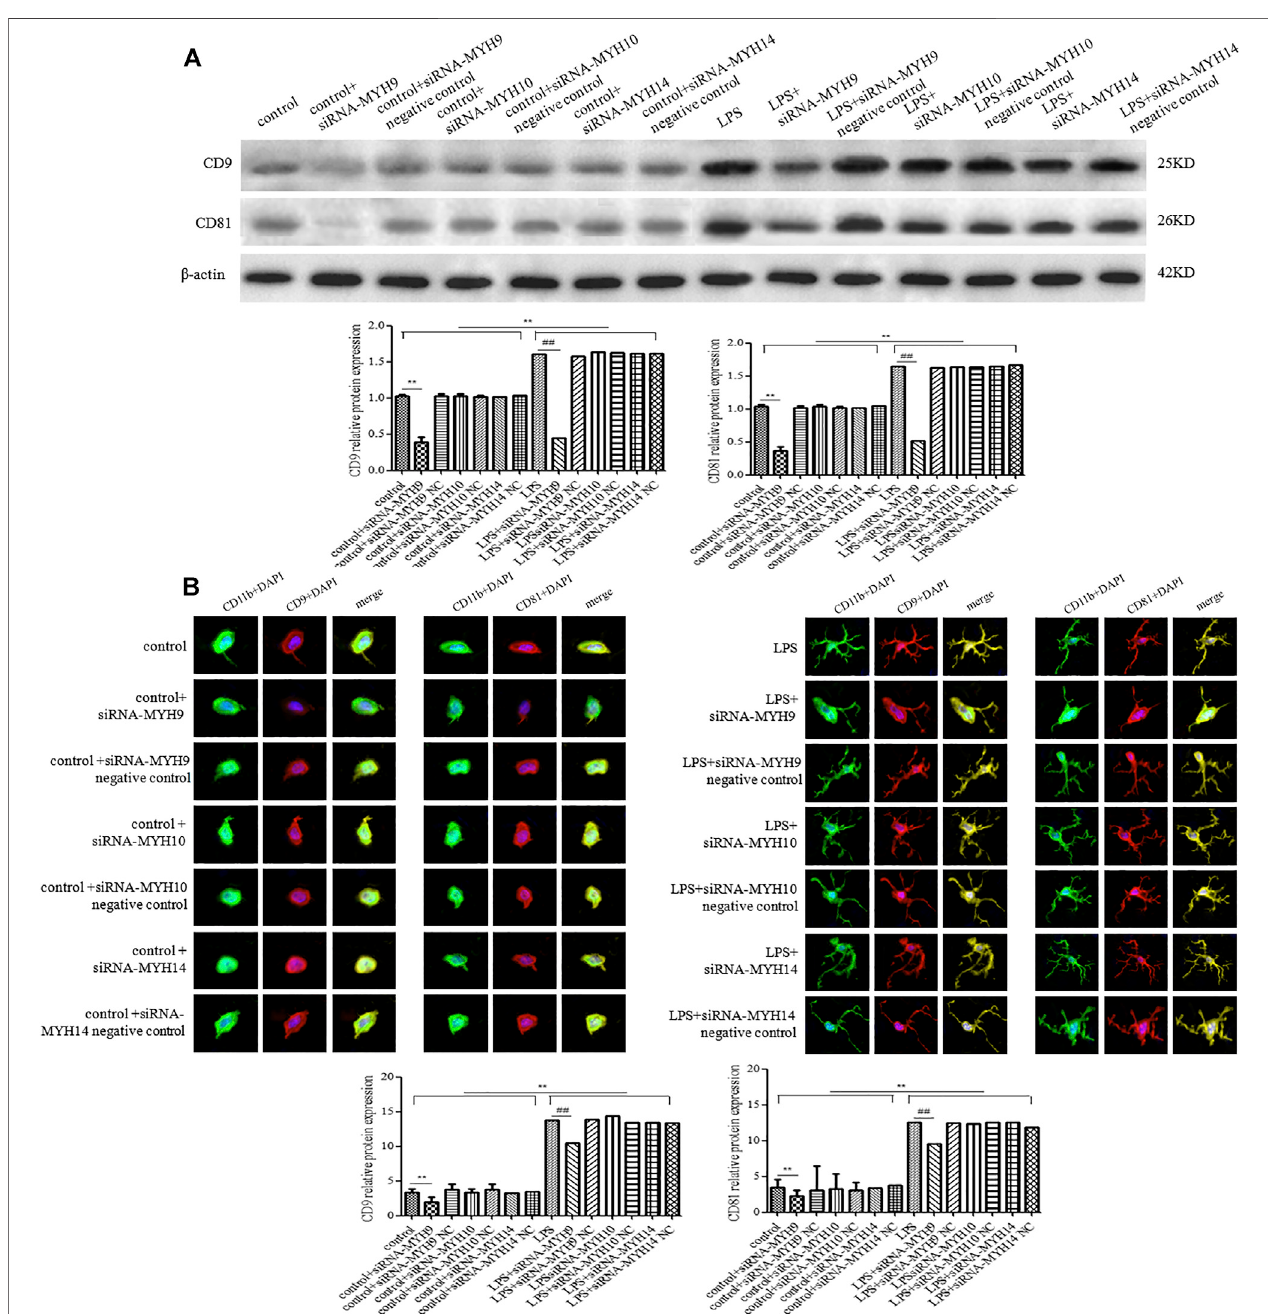
FIGURE 5 | Transfection of siRNA-MYH9, but not siRNA-MYH10 or siRNA-MYH14 inhibited exosome release from microglial cells stimulated by LPS. For transfection,microglialcellsweresub-culturedin24-wellplatesatadensityof3 × 10 5 cells/ml.TheextractedexosomesweregroupedbasedontransfectionwithsiRNA or siRNA into microglial cells. Whether control or LPS stimulation cells were transfected with siRNA-MYH9, siRNA-MYH10, or siRNA-MYH14 at a fi nal concentration of 100 nM for 48 h. Microglial cells stimulated by 1 mg/ml LPS for 24 h, microglial cells transfected with siRNA followed by 24 h LPS stimulation, microglial cells transfectedwithsiRNAnegativecontrolfollowedby24 hLPSstimulation. (A) TheCD9andCD81proteinexpressionlevelsforeachgroupofexosomewereexaminedby western blotting. Western blots were quanti fi ed. Nine independent experiments were analyzed. A histogram depicted the quantitative representations of the protein expressionlevelsofCD9andCD81foreachgroup. (B) Microglialcellswereimmuno fl uorescentlystainedwithanti-CD9oranti-CD81(red),togetherwithCD11b(green), and DAPI for nuclei (blue). Stained cells were examined by confocal microscopy. Scale bars (cid:2) 10 μ m. A histogram depicted the quantitative fl uorescence intensities of CD9 or CD81 from a total of 45 randomly selected cells from nine independent experiments in each group of microglial cells. Nine independent experiments were analyzed. A histogram depicted the quantitative representations of the protein expression levels ofCD9 and CD81 for each group. The data were averages with SD, n (cid:2) 9. ** p < 0.01 vs. control microglial cells; ## p < 0.01 vs. microglial cells stimulated with LPS.